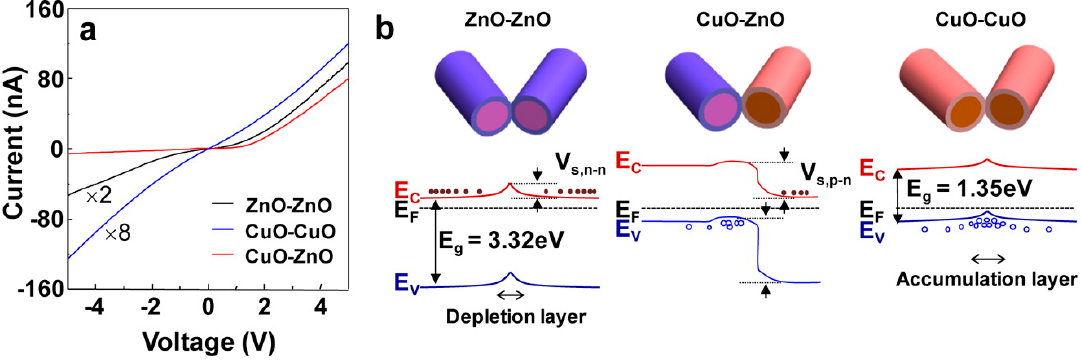
Figure 3. Comparison of contacts between ZnO and CuO NWs: ( a ) current-voltage (I-V) curves obtained at room temperature, demonstrating the characteristic nonlinear Schottky-like transport behavior; ( b ) Energy band diagram for every interconnection type between NWs. Reproduced with permission from [45]. Copyright American Chemical Society, 2013.